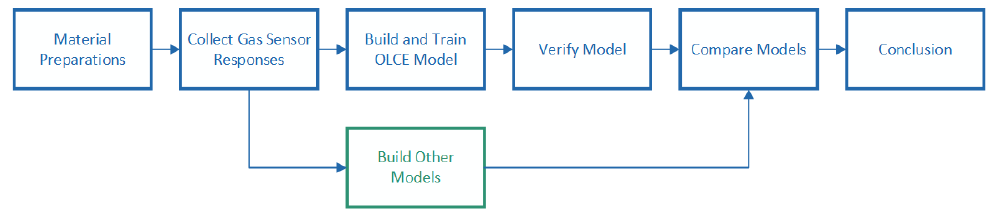
Figure 1. Odor Labeling Convolutional Encoder–Decoder (OLCE)